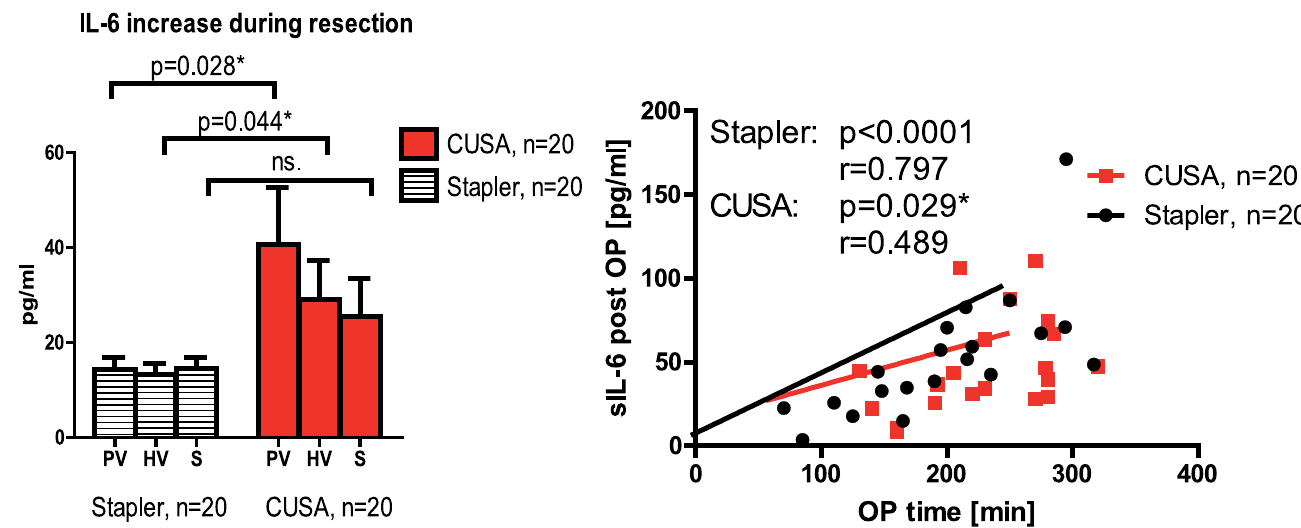
Fig 3. Stapler liver resection leads to a decreased IL-6 response compared to CUSA transection. (A) IL-6 production was numerical higher in patients undergoing CUSA resection, though the observed difference did not reach statistical significance. Cytokines levels are shown as means ± SEM. (B) Calculating the specific IL-6 response during liver resection revealed a significantly higher increase in the portal vein (PV) (p = 0.028) and hepatic vein (p = 0.044) but not systemically in patients in the CUSA group. (C) There was a strong correlation between systemic IL-6 measured immediately after skin closure and length of operation (CUSA: p = 0.029, r = 0.489; Stapler: p < 0.0001, r = 0.797; Overall: p < 0.0001, r = 0.6188).